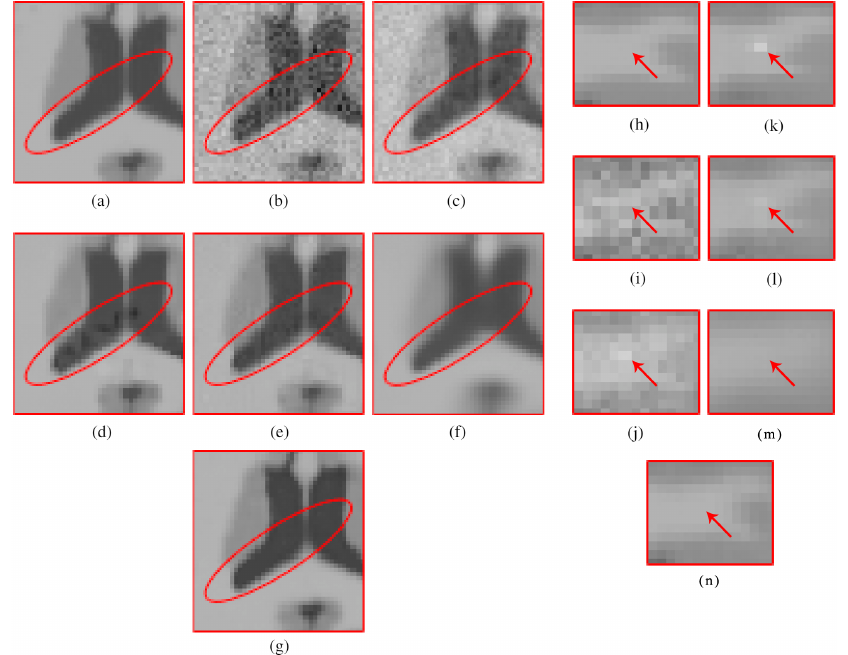
Figure 7. Zoom-in on the details of the regions labeled as “d” and “b” in Figure 6. Figure ( a – g ) show the detail labeled as “d” in Figure 6a–g respectively. Figure ( c – g ) Correspond to the methods KSVD, PRINLM, BM4D, DnCNN and NLSD, respectively. Figure ( h – n ) show the detail labeled as “b” in Figure 6a–g respectively. Figure ( j – n ) Correspond to the methods KSVD, PRINLM, BM4D, DnCNN, and NLSD, respectively.